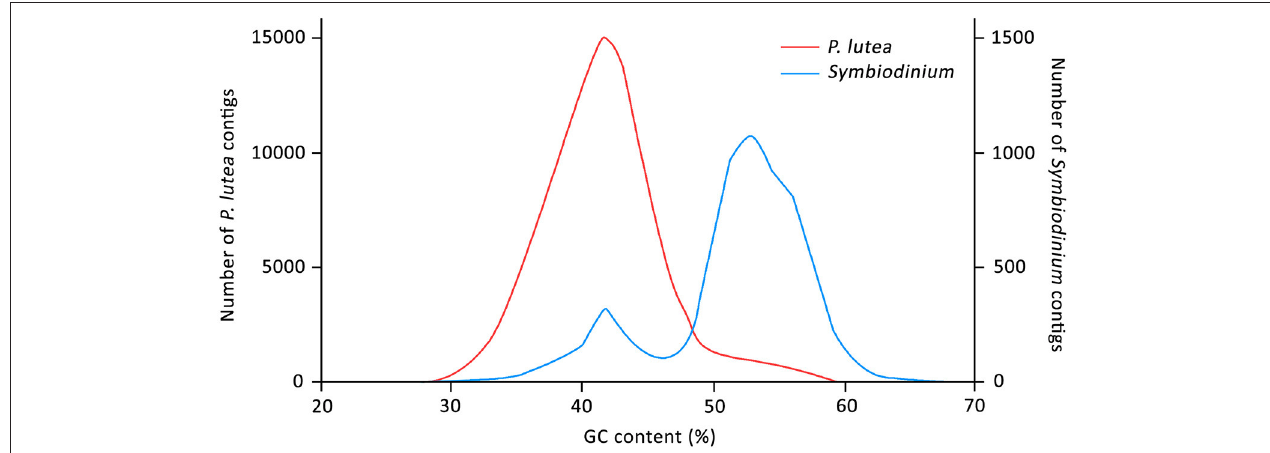
FIGURE 1 | Distribution of GC content (in percentage) of the assembled transcripts. Red and blue lines represent coral- and Symbiodinium -specific transcripts, respectively.